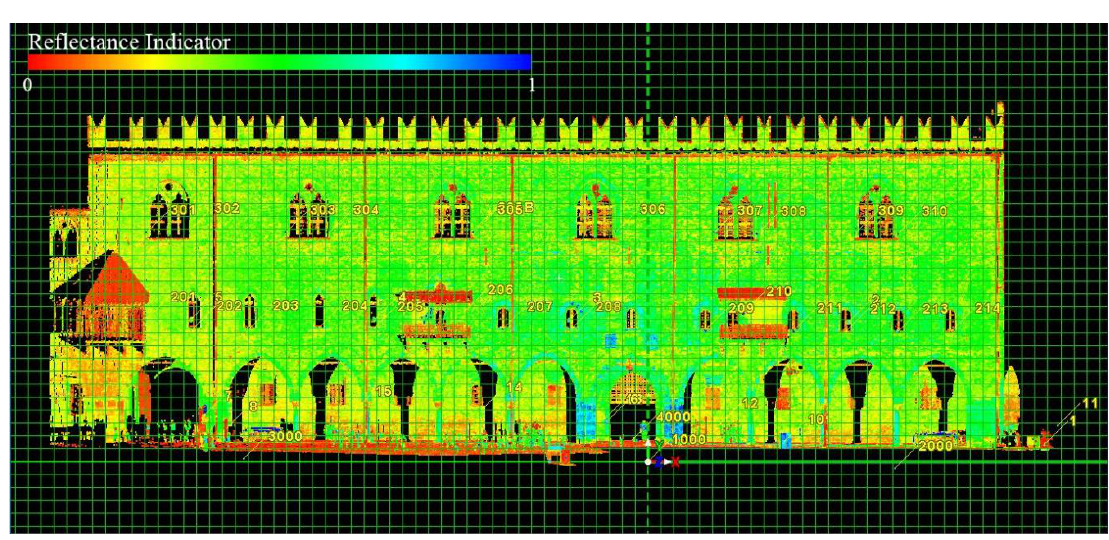
Figure 15. Cyclone. Point cloud of the Palazzo del Capitano façade in the new local reference system with the axes rotated. Hue expresses the reflectance of the surface materials acquired by the